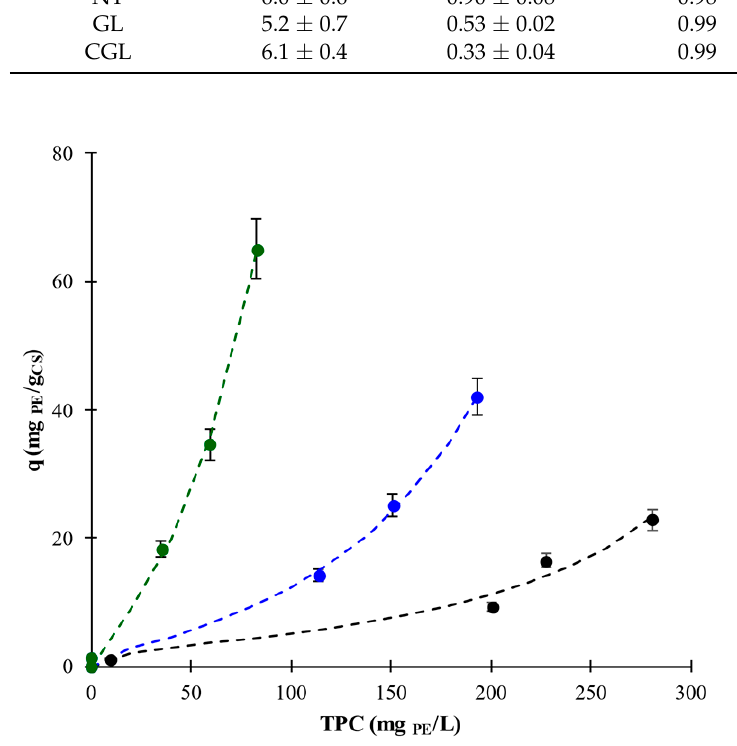
Figure 3. Adsorbed/retained polyphenols by CS, q, vs. TPC of aqueous phase for AF–CS samples